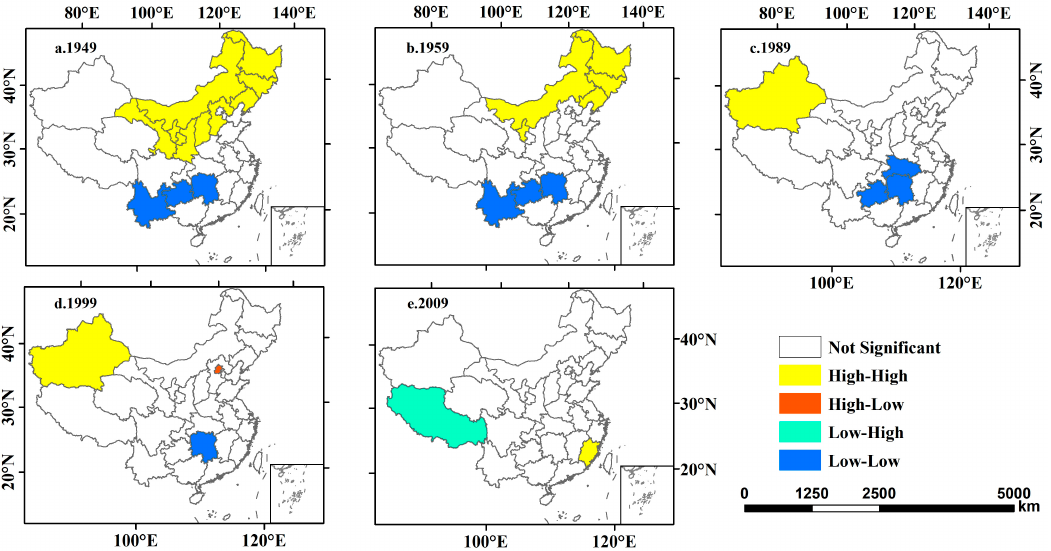
Figure 7. Local indicator of spatial association (LISA) aggregation map of the comparative advantages of soybean planting efficiency in China.